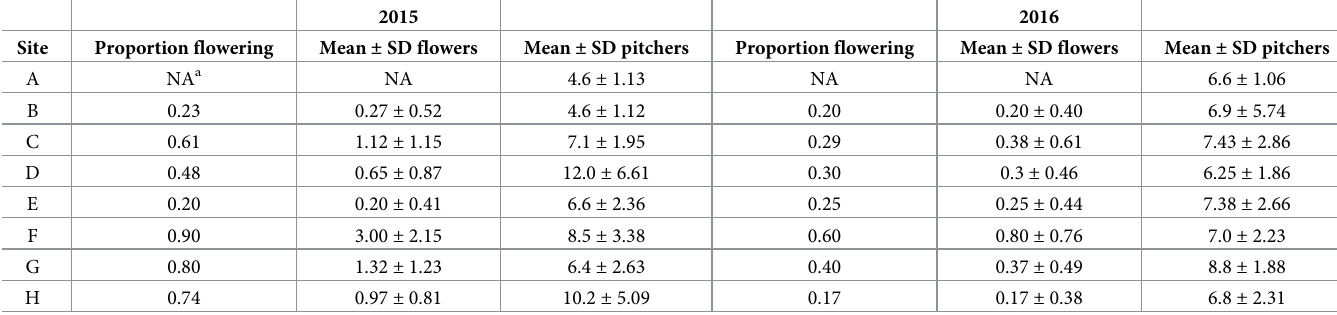
Table 5. Proportion of rosettes that had flowers, Mean ± SD number of flowers, and Mean ± SD number of pitchers produced in 2015 and